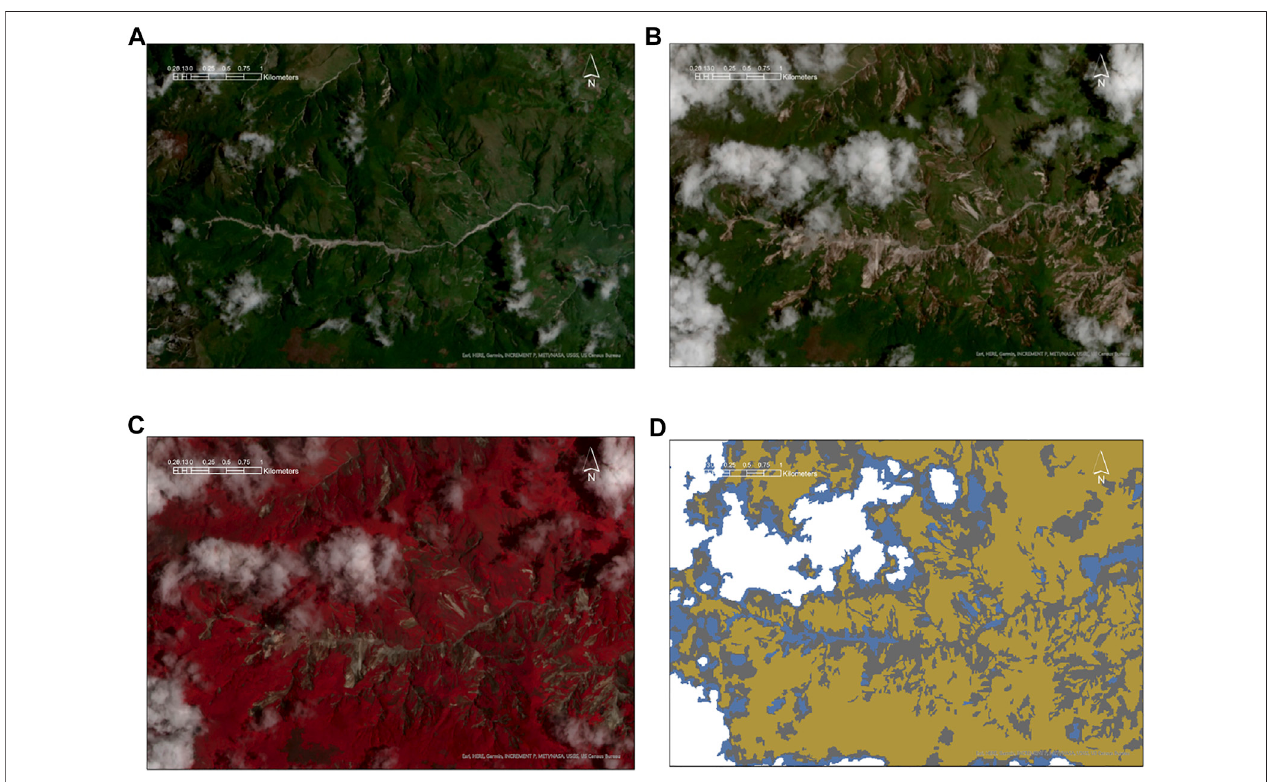
FIGURE 8 | Sentinel-2 true colour Imagery (A) before and (B) after the earthquake. (C,D) processed multi-spectral Sentinel-2 imagery change detection images.